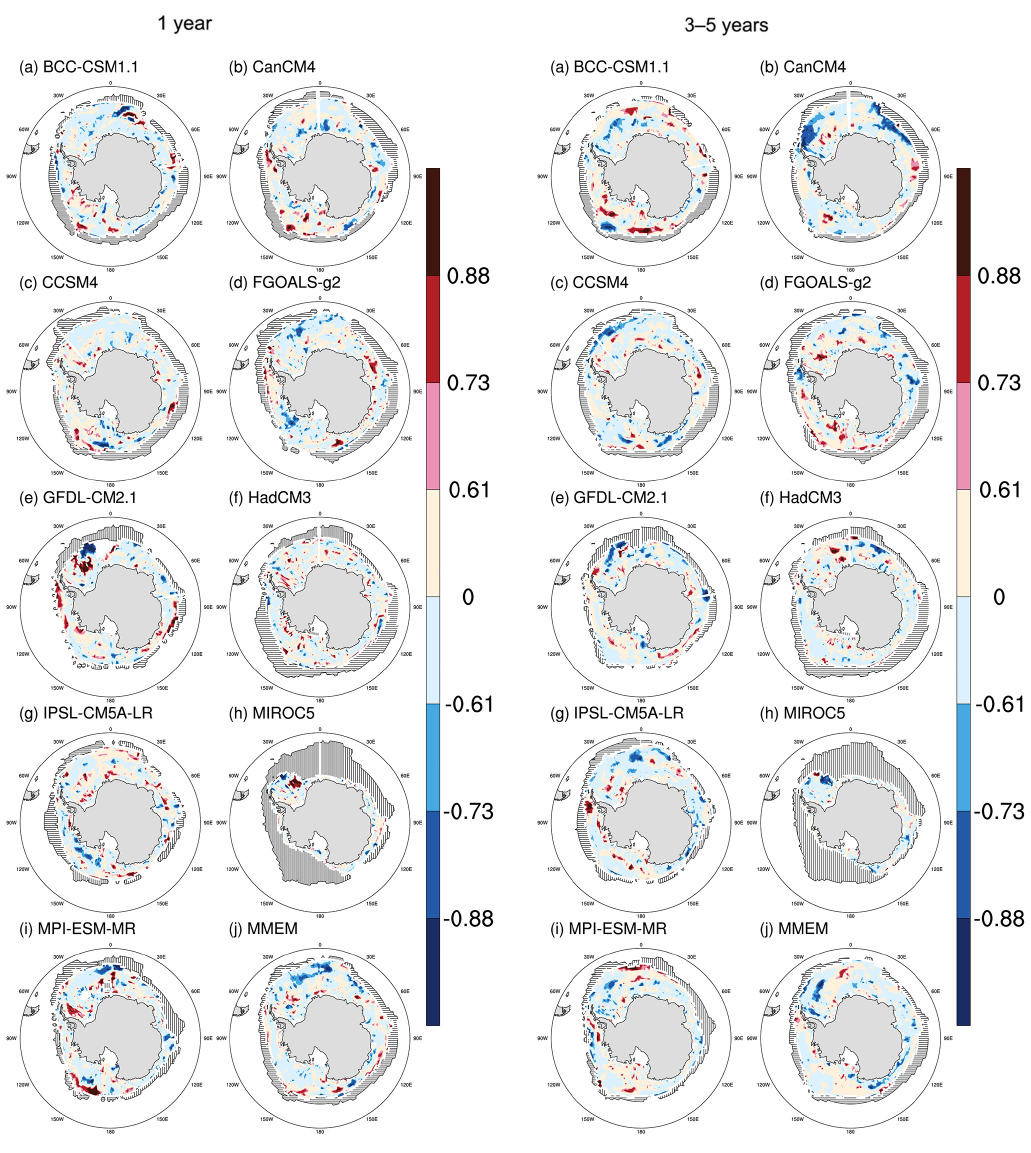
Figure 16. Anomaly correlation coefficients between the simulated and observed Antarctic September sea ice concentration anomalies for the lead time of 1 year (left panel) and 3–5 years (right panel). The correlation coefficients of 0.61, 0.73, and 0.88 represent 90, 95, and 99% confidence levels, respectively. Horizontal lines depict the areas where the model simulation has sea ice, whereas the observation does not have sea ice. The opposite is the case for vertical